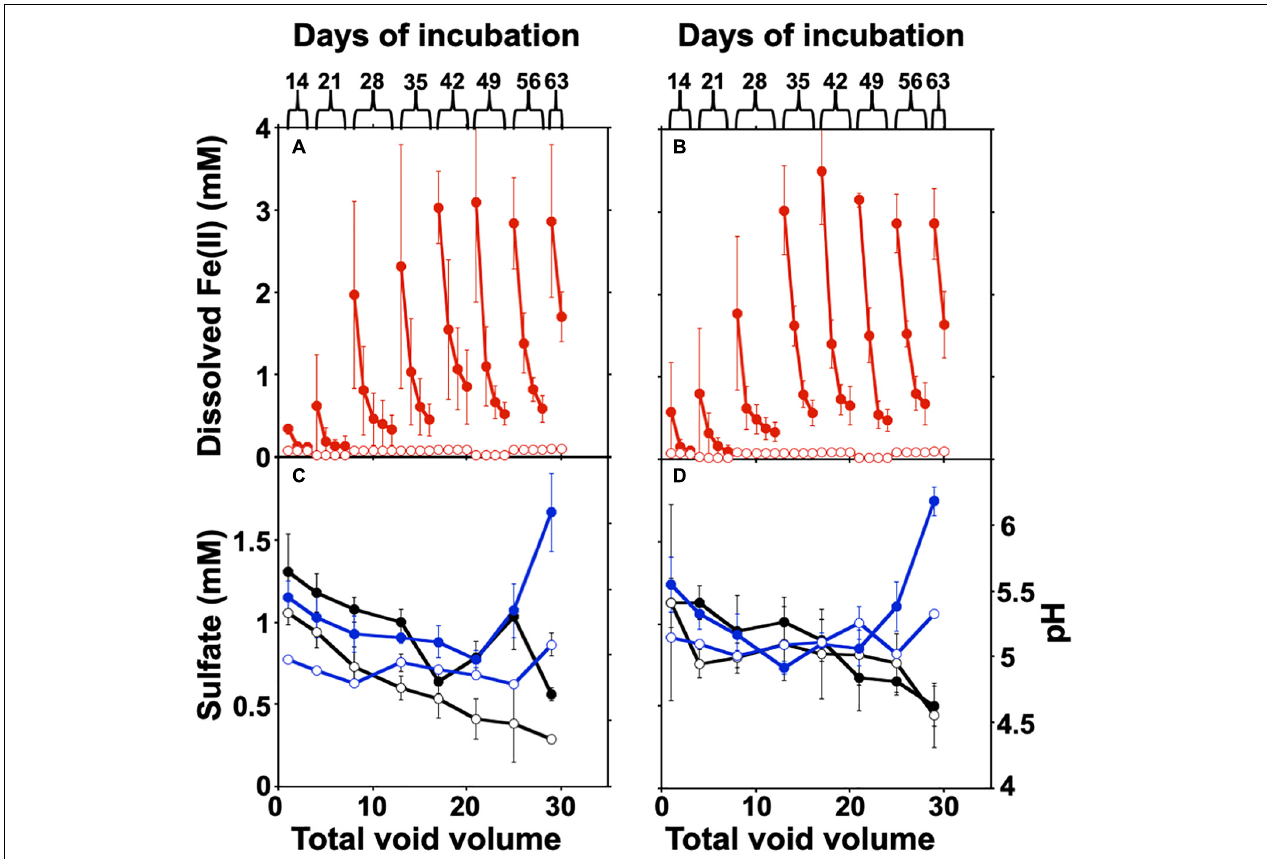
FIGURE 4 | Fe(III) reduction and changes in sulfate and pH in the column experiments. (A,B) Columns were operated semi-continuously, and sulfate and pH were measured in each pore volume (four volumes) recovered after each static incubation. The column was disassembled after two column volumes at day 63 for post mortem analysis. Error bars represent one standard deviation of triplicate columns. The concentration of dissolved Fe(II) is shown at pH 4.75 (A) and 6.8 (B) . Sulfate concentrations (black) and pH (blue) in column effluents are shown in panels (C) (pH 4.75) and (D) (pH 6.8). The values for uninoculated columns are shown with open circles, with the sub muros -inoculated columns represented by closed circles.